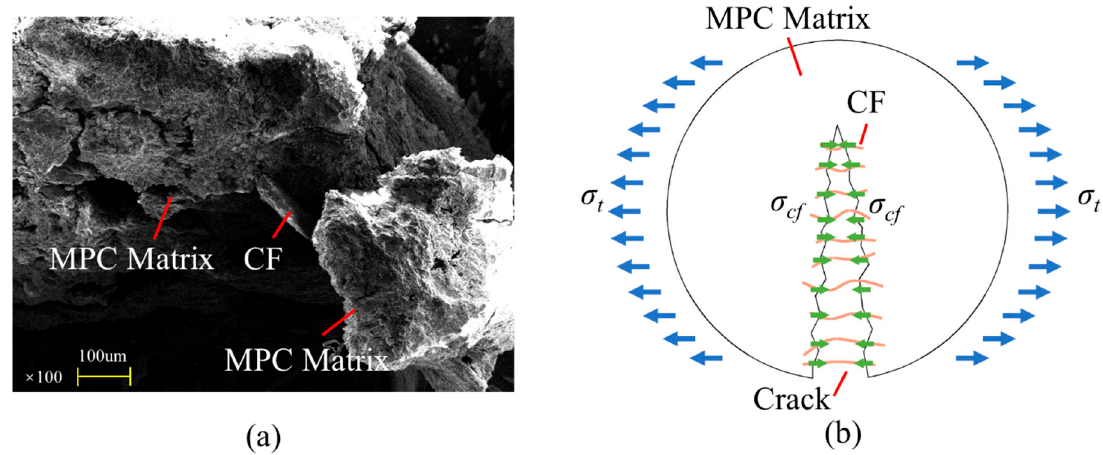
Figure 18. Bridge e ff ect: ( a ) SEM for CF connection; ( b ) schematic. Figure 18. Bridge effect: ( a ) SEM for CF connection; ( b ) schematic. Figure 18. Bridge effect: ( a ) SEM for CF connection; ( b ) schematic.